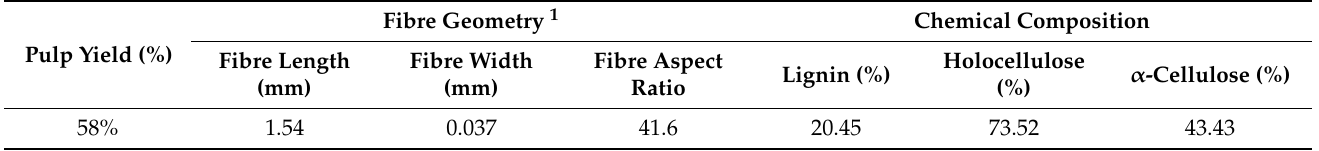
Table 1. Properties the OPT chemi-themomechanical pulps used in this study.